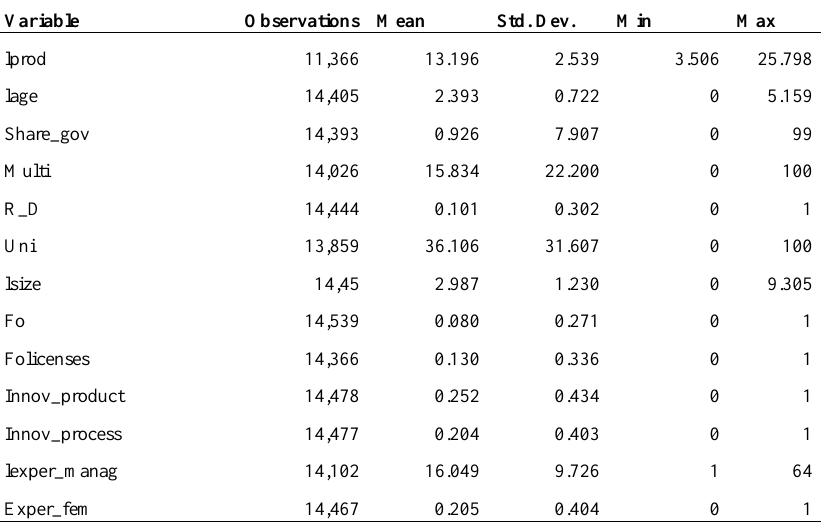
Table 3. Summary